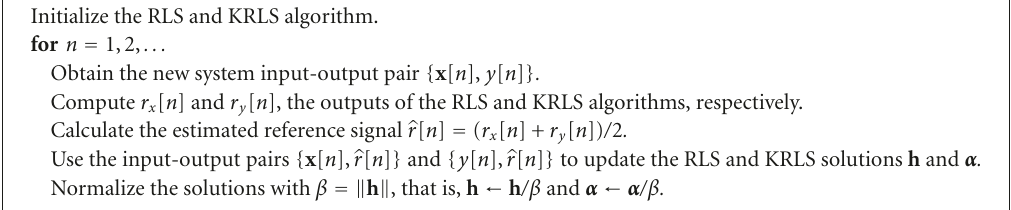
Algorithm 1: The adaptive kernel CCA algorithm for Wiener system identification.